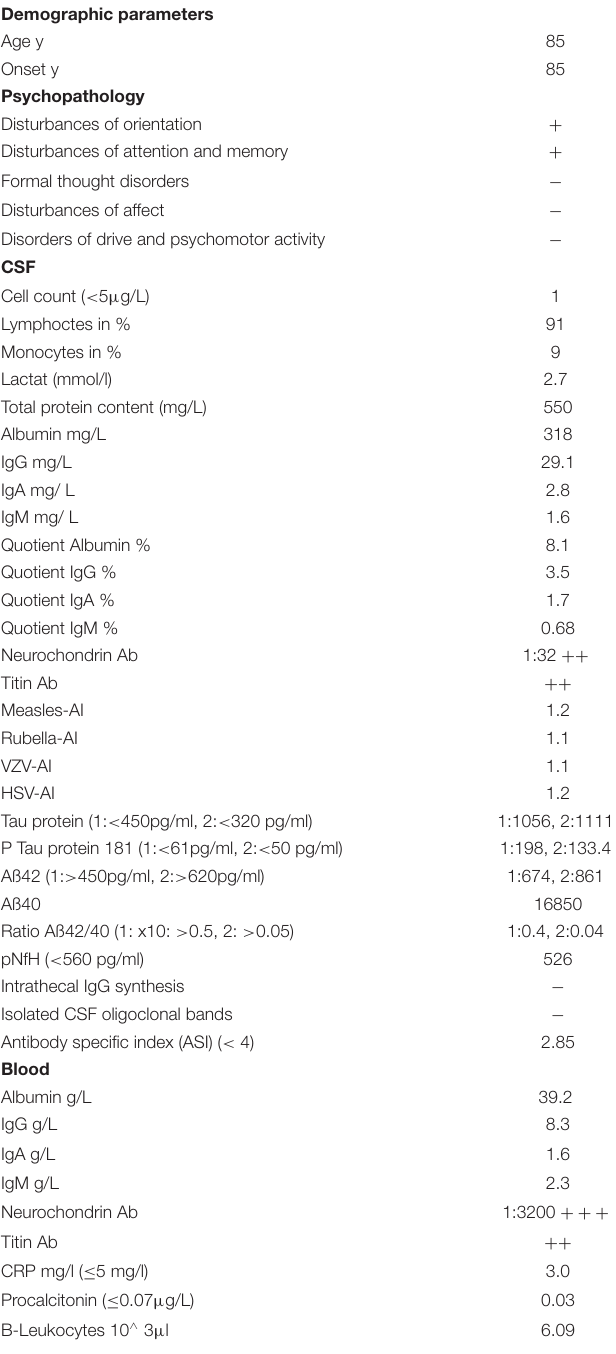
TABLE 1 | Clinical and laboratory